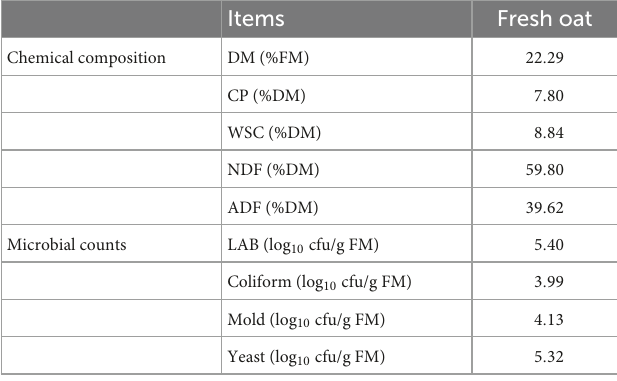
TABLE 1 Chemical characteristics and microbial counts of fresh oat before fermentation. Items Fresh